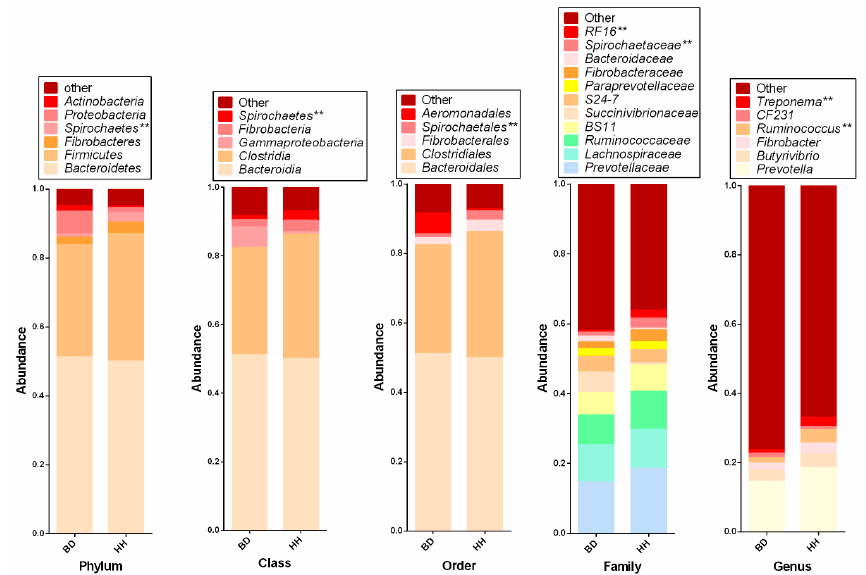
Figure 1. Distribution of predominant bacteria (abundance > 1%) in rumen content. BD = brisket disease group, n = 5; HH = healthy heifer group, n = 5; **: p < 0.05.